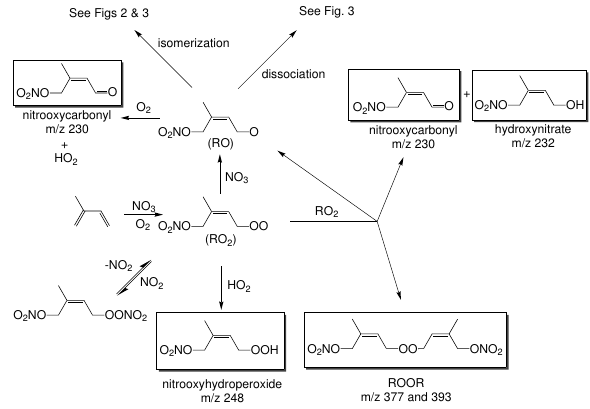
Fig. 1. Generalized reaction mechanism of the isoprene+NO 3 reaction. Boxed compounds are detected by CIMS instrument as CF 3 O − adducts at the indicated m/z values.